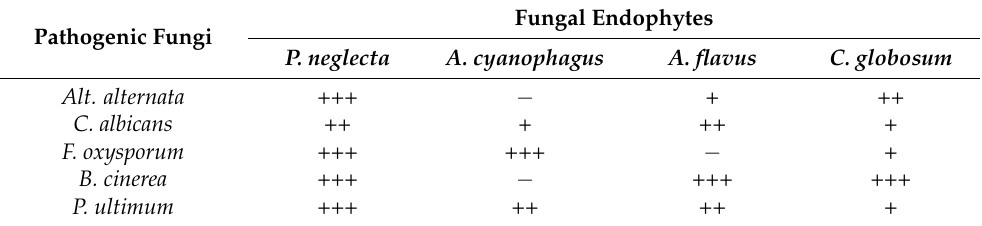
Table 2. Antifungal activity of endophytic fungi isolated from Z. spina-christi against pathogenic fungi according to the dual culture.